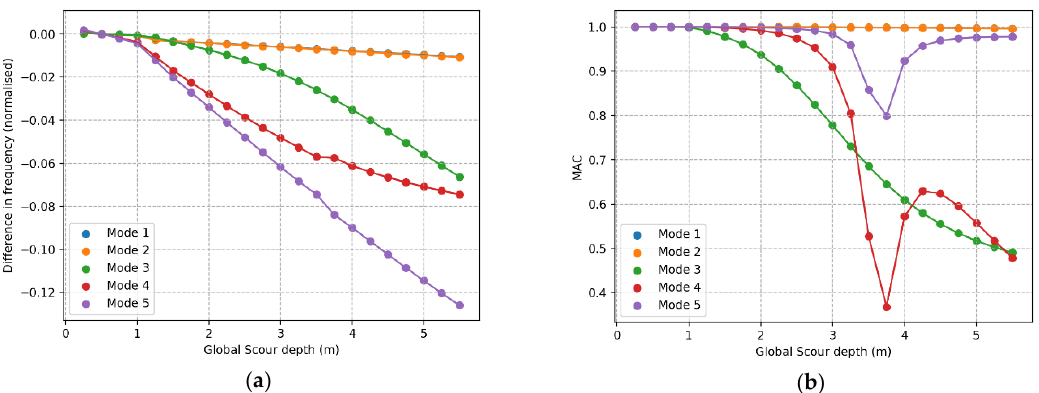
Figure 12. Effect of gradually increased depth of global scour, compared to 0 scour depth. Modes compared based on maximized MAC ( a ) Difference in natural frequency, ( b ) MAC value. Scour depth in meters for the 23 m × 23 m jacket.